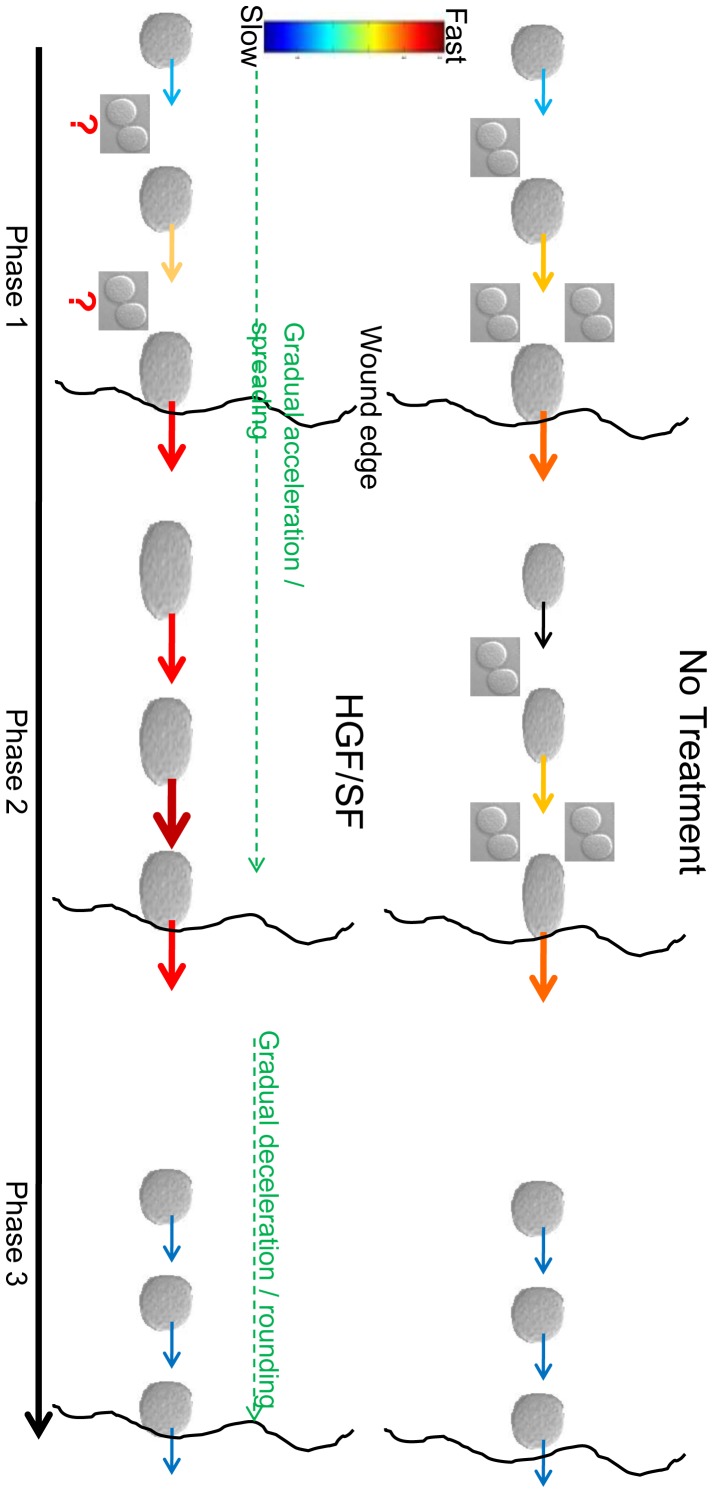
Model for HGF/SF-induced collective motility patterns during the healing process.HGF/SF dramatically alters the morpho-dynamics of the healing wound: from a simple model, in which the front cells lead the healing in constant acceleration, to a more elaborate model in which cells in different distances from the wound lead a coordinated increased motility along with spatio-temporal phenotypic EMT-MET based collective cell motility dynamics. Untreated DA3 front layers cells are larger, more elliptical and move faster (marked by wider arrows) than cells located behind demonstrating a homogeneous motility pattern during the wound healing process (Phases 1 and 2). During post wound closure (Phase 3), all cells decelerate, shrink and round up regardless of their position. HGF/SF treatment leads to the emergence of dramatic different cell motility patterns: at the beginning, front cells are larger, more elliptical and move faster than distant cells. Throughout Phase 1, distant cells become larger, more elliptical and gradually join the rapid motion by accelerating layer by layer. These morphology changes and gradual acceleration continues during Phase 2, were distant cells maintain a higher velocity toward the wound than cells located closer to the wound edge. Finally, post wound closure (Phase 3), front cells shrink, round up and halt, while distant cells gradually decelerate, and change morphology in a similar manner. It is hypothesized that accelerated proliferation at the leading edge is the answer for the untreated cells gap mystery presented in the text. It is hypothesized that in treated cells proliferation occurs more intensively, but is spread approximately equally throughout the monolayer.